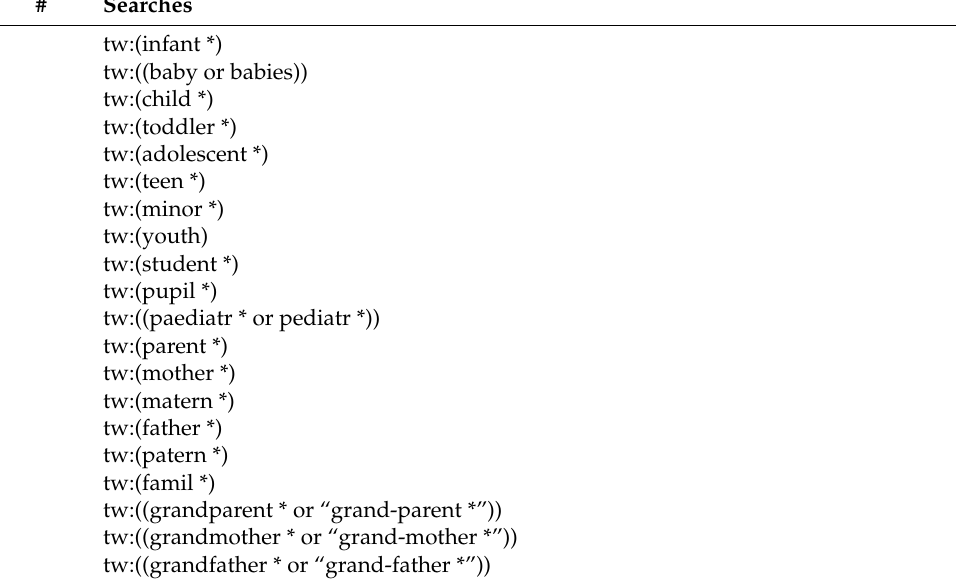
Table A5. Search